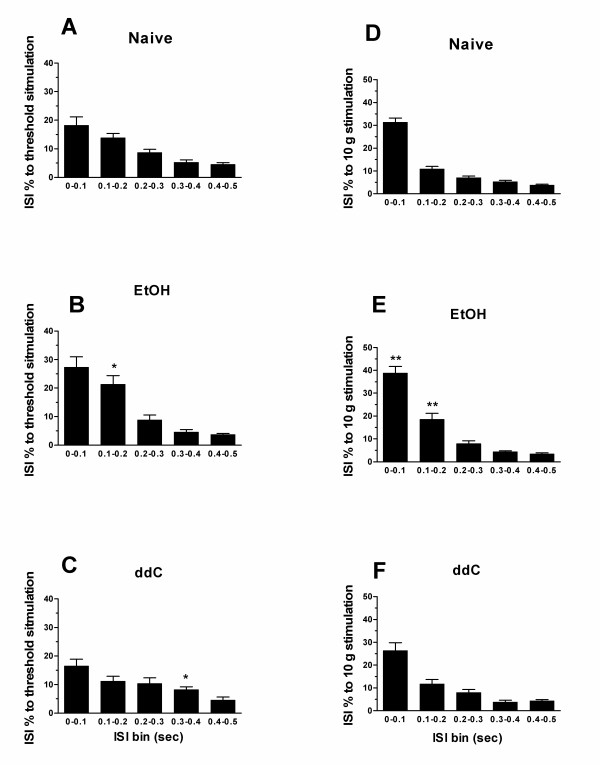
The ISI distributions of both EtOH (n = 15) group of C-fibers in responses to sustained (60 sec) threshold and 10 g stimuli were significantly changed. A&D, the ISI distributions of control C-fibers (n = 38) in responses to sustained threshold and 10 g stimuli, respectively. B&C, ISI 0.1–0.2 s of responses in EtOH group was significantly higher than that of controls (p < 0.05, t-test) and ISI 0.3–0.4 s of responses in ddC group (n = 18) was significantly higher than that of controls (p < 0.05, t-test). E&F, the ISI distributions of EtOH group in responses to 10 g stimulation were significantly changed while the ISI distributions of ddC group were similar to those of controls. ISI 0–0.2 s of responses in EtOH group was significantly higher than those of control animals (p < 0.01, t-test)